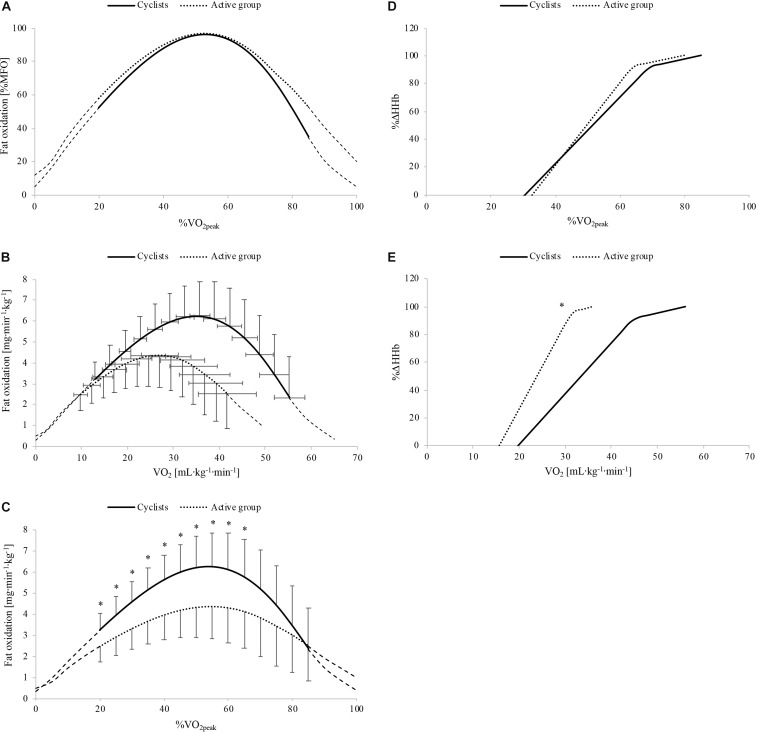
Whole-body fat oxidation kinetics in relative (A) and absolute (B,C) values and muscle deoxygenation kinetics as a function of relative (D) and absolute (E) exercise intensity in cyclists (black line) and active people (black dots). Δ[HHb], variation in deoxygenated hemo- and myoglobin concentration; MFO, maximal fat oxidation; V.O2⁢p⁢e⁢a⁢k, peak oxygen uptake. ∗Significant difference between the cyclist and active group (p ≤ 0.05).